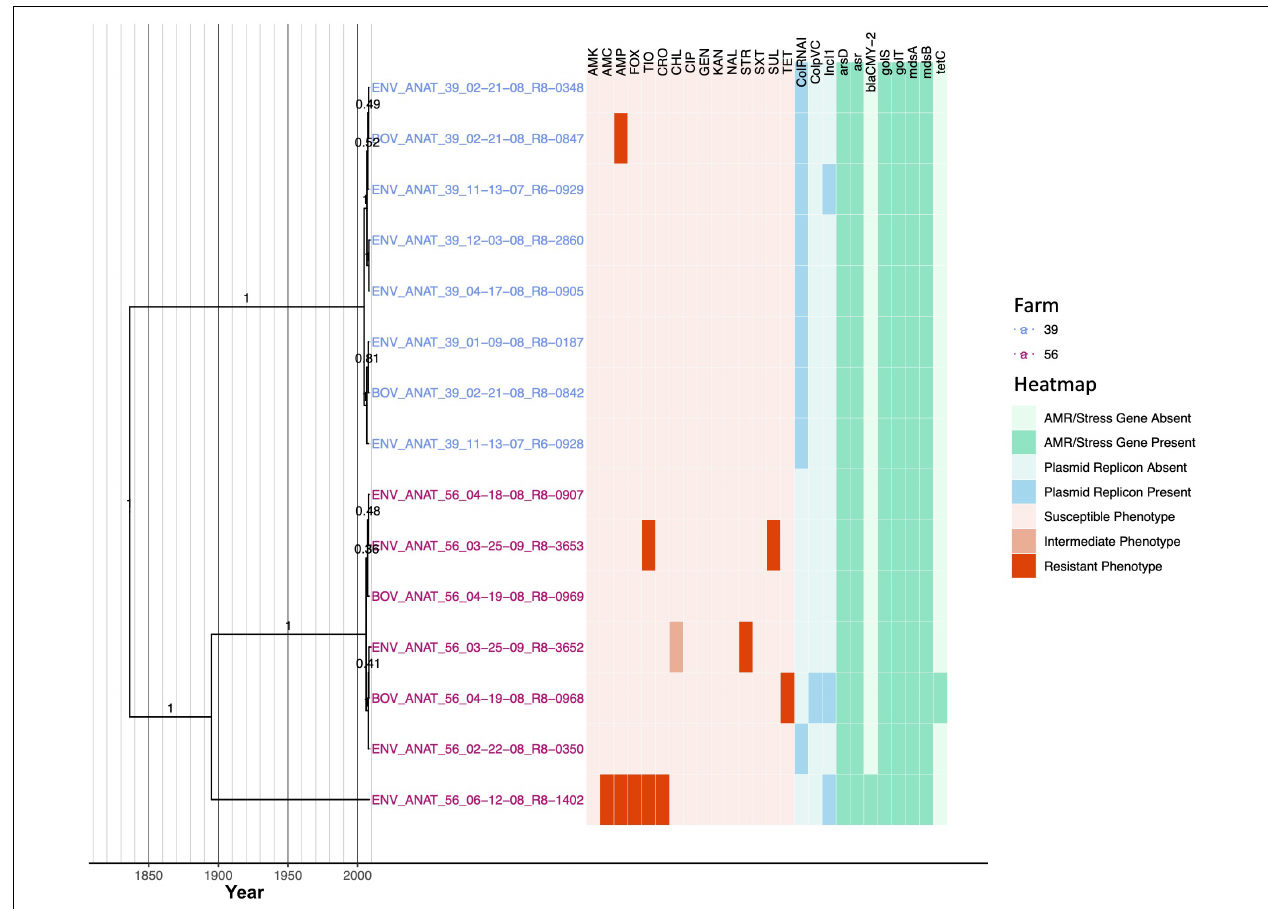
FIGURE 5 | Rooted, time-scaled maximum clade credibility (MCC) phylogeny constructed using core SNPs identified among 15 Salmonella Anatum genomes isolated from subclinical bovine sources and the surrounding bovine farm environment. Tip label colors denote the ID of the farm from which each strain was isolated. Branch labels denote posterior probabilities of branch support. Time in years is plotted along the X -axis, and branch lengths are reported in years. The heatmap to the right of the phylogeny denotes (i) the susceptible-intermediate-resistant (SIR) classification of each isolate for each of 15 antimicrobials (obtained using phenotypic testing and NARMS breakpoints; orange); (ii) presence and absence of plasmid replicons (detected using ABRicate/PlasmidFinder and minimum nucleotide identity and coverage thresholds of 80 and 60%, respectively; blue); (iii) presence and absence of antimicrobial resistance (AMR) and stress response genes (identified using AMRFinderPlus and default parameters; green). Core SNPs were identified using Snippy. The phylogeny was constructed using the results of ten independent runs using a strict clock model, the Standard_TVMef nucleotide substitution model, and the Coalescent Bayesian Skyline population model implemented in BEAST version 2.5.1, with 10% burn-in applied to each run. LogCombiner-2 was used to combine BEAST 2 log files, and TreeAnnotator-2 was used to construct the phylogeny using median node heights. Abbreviations for the 15 antimicrobials are: AMK, amikacin; AMC, amoxicillin-clavulanic acid; AMP, ampicillin; FOX, cefoxitin; TIO, ceftiofur; CRO, ceftriaxone; CHL, chloramphenicol; CIP, ciprofloxacin; GEN, gentamicin; KAN, kanamycin; NAL, nalidixic acid; STR, streptomycin; SXT, sulfamethoxazole-trimethoprim; SUL, sulfisoxazole; TET,